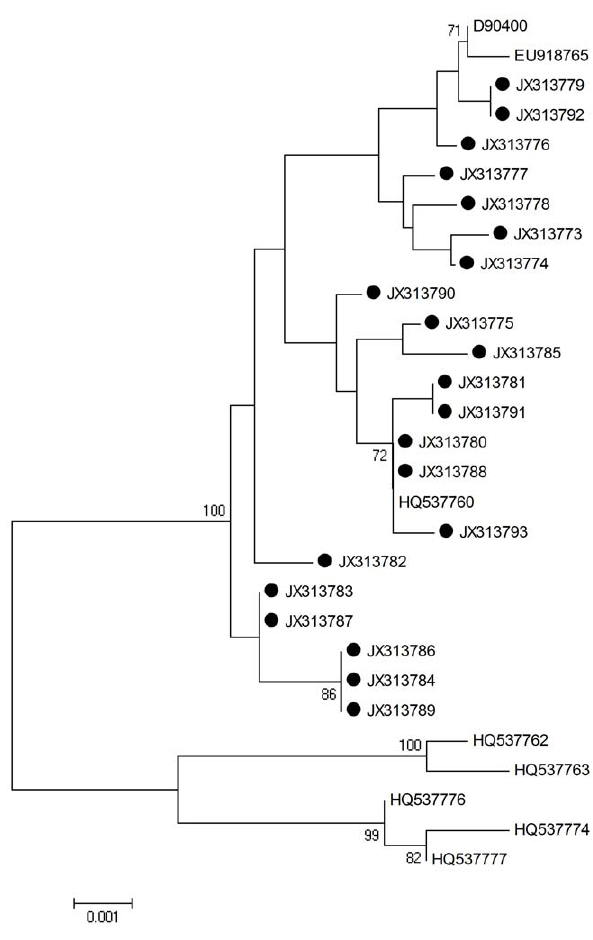
Figure 4. Neighbor joining phylogenetic tree generated using nucleotide sequences of the HPV-58 L2 gene. Study sequences are labeled in black. Others are standard sequences, including: D90400 (Japan), EU918765, HQ537760 (isolate AS347), HQ537762, HQ537763, HQ537776, HQ537774, and HQ537777. Phylogenetic trees were constructed by the Neighbor-Joining method and the Kimura 2- Parameter model by MEGA package.